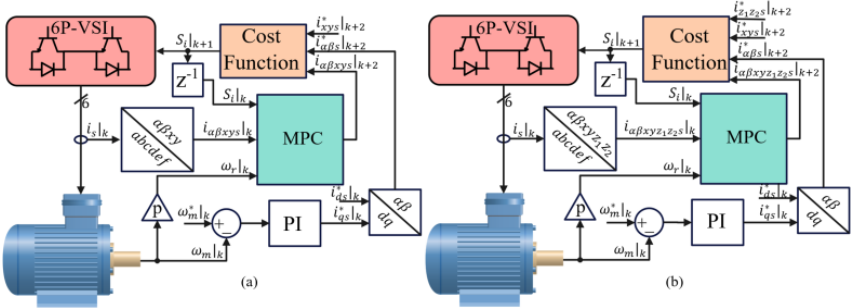
Figure 4. MPC scheme for an ASPIM: ( a ) single isolated neutral configuration; ( b ) dual isolated neutral configuration.